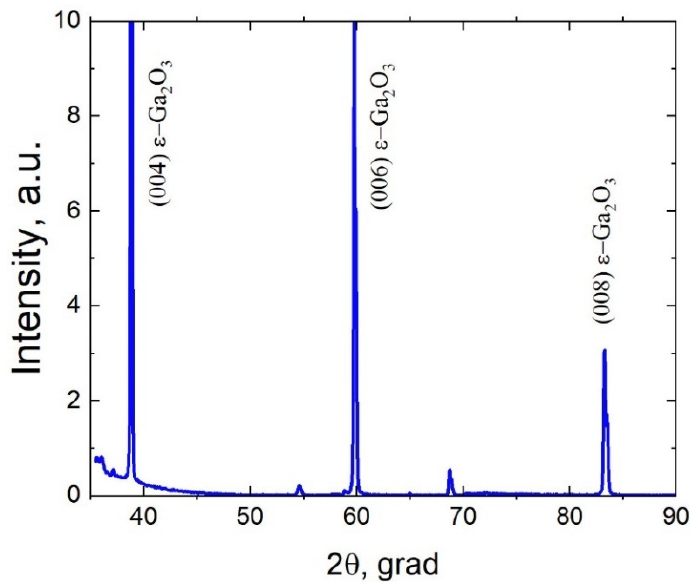
Figure 8. XRD spectrum of an 𝜀 -Ga 2 O 3 sample grown on the 3C-SiC(111)/Si(111) hybrid substrate at 570 °C.